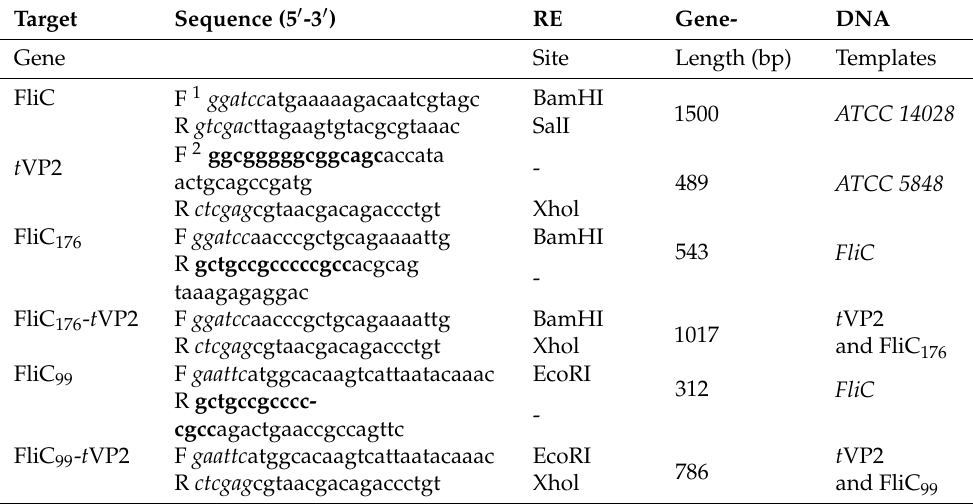
Table 1. Primers for gene cloning and recombinant protein